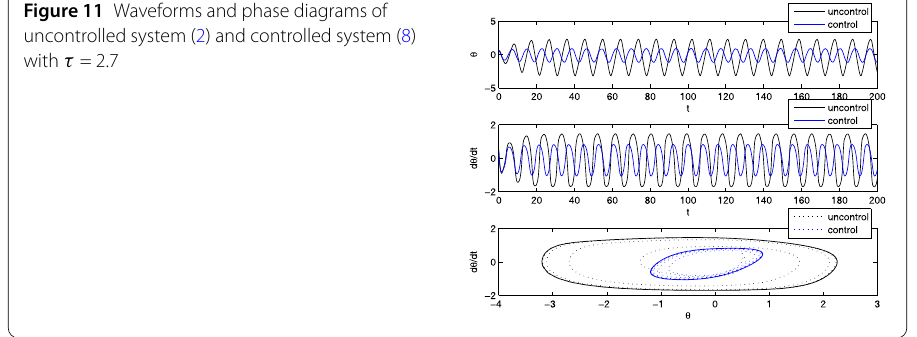
Figure 12 Waveforms and phase diagrams of uncontrolled system (2) and controlled system (8) with τ =